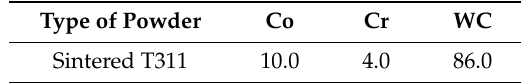
Table 1. Chemical composition (wt%) of the powder.